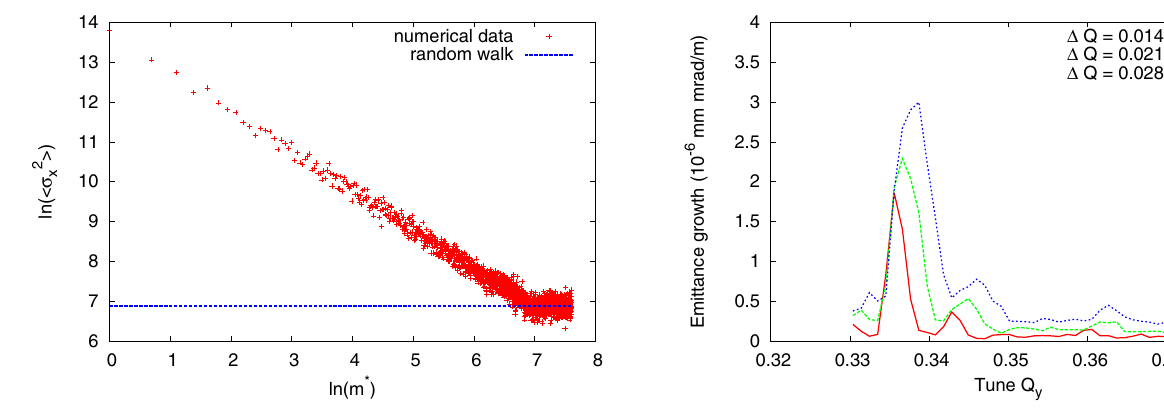
FIG. 11. Averaged second order moment h σ 2 random kicks for different periodicities m (cid:3) . The blue line indicates the second order moment for the nonperiodic random walk (without